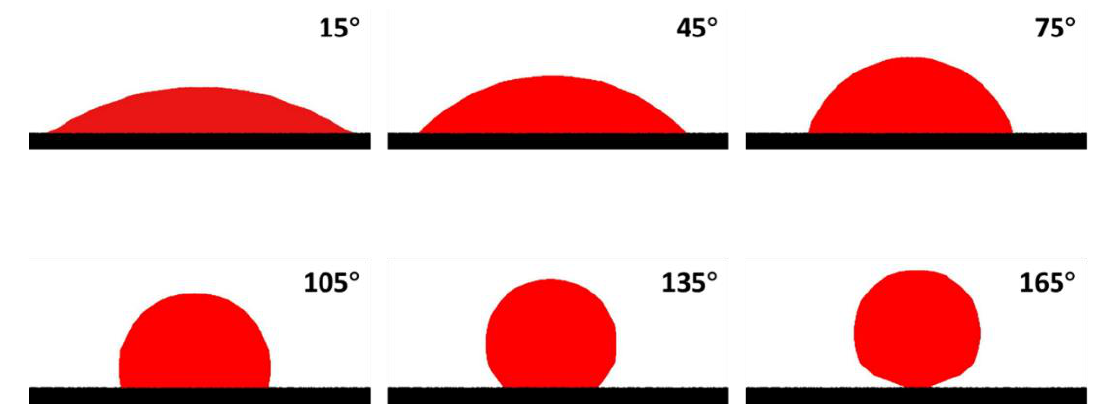
Figure 4. Various configurations of the contact angle between two-phase fluids.